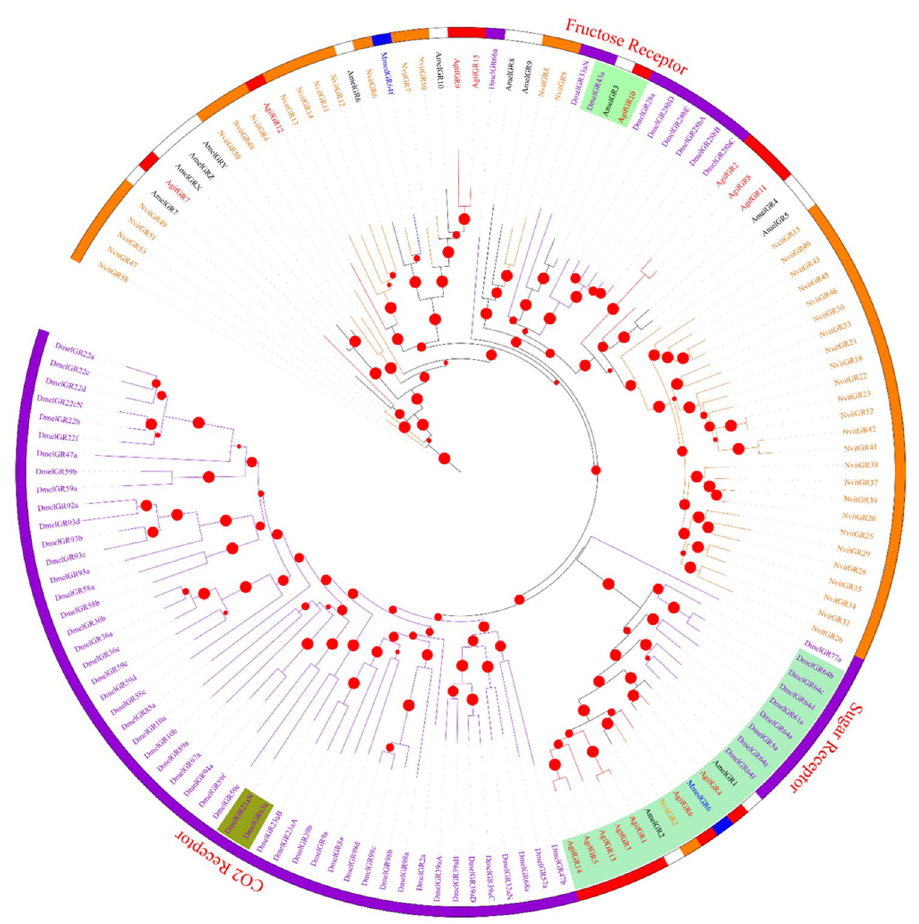
Figure 5. Maximum likelihood phylogenetic tree of gustatory receptors (GRs). Included are ORs from Aphidius gifuensis (Agif), Microplitis mediator (Mmed), Apis mellifera (Amel), Drosophila melanogaster (Dmel), and Nasonia vitripennis